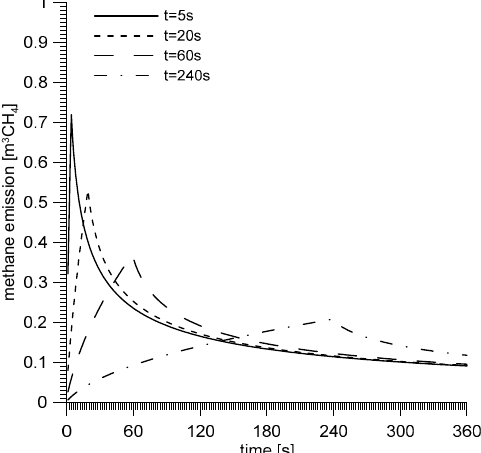
Figure 16. A model methane emission based on a sphere during the Budryk outburst.